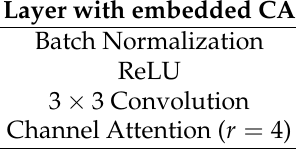
Figure 6. Composition of the dense